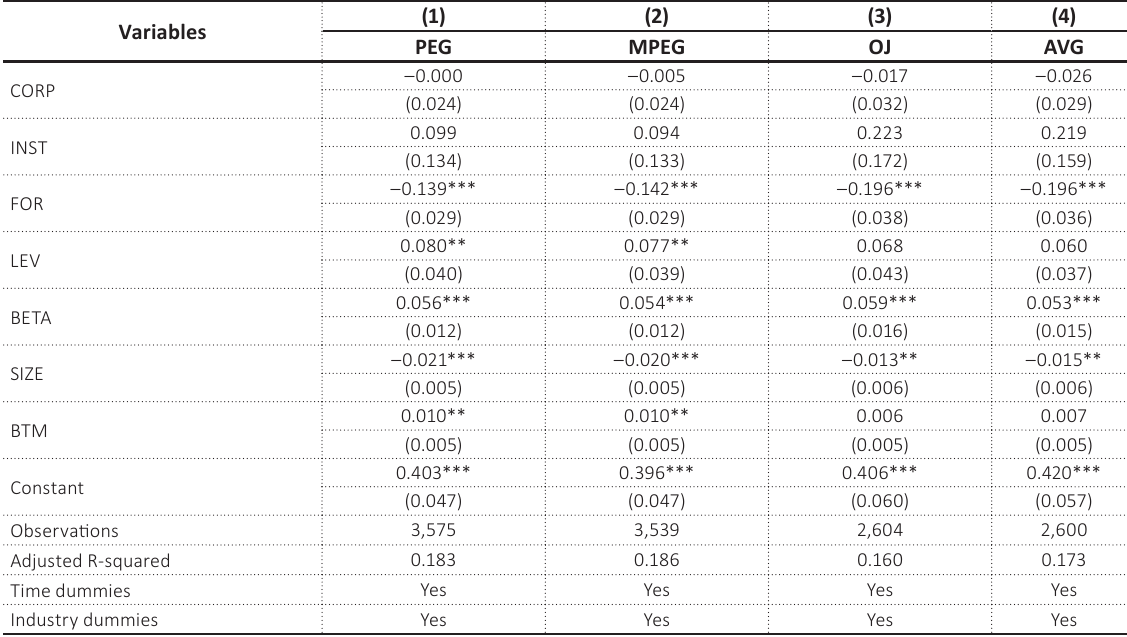
Note : Columns 1 through 4 of Table 1 present the regression analysis results that examine the relationship between holding variables and the ICC models as expressed in Equation 1. The clustered firm-level standard errors are in parentheses. The model is estimated with pooled OLS with industry and time dummies. *** p < 0.01, ** p < 0.05, * p <